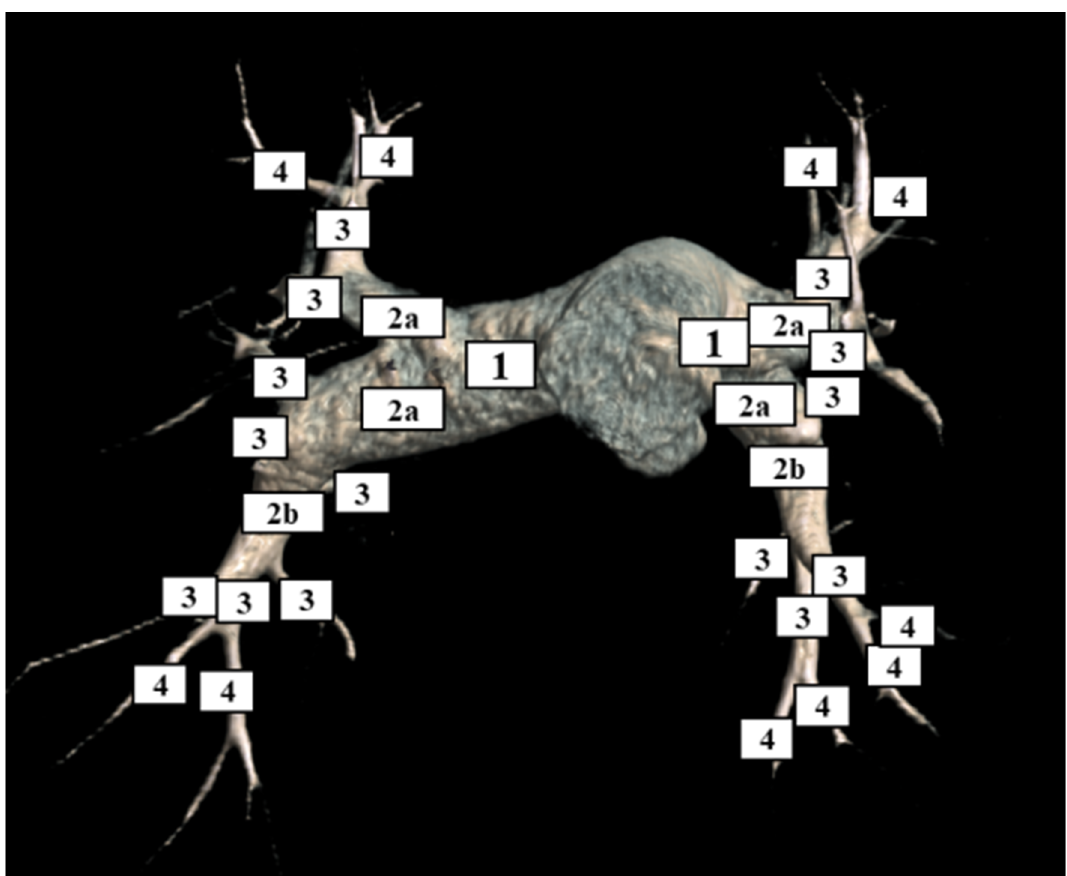
Figure 1. Computed tomography volume rendering of the pulmonary arteries illustrating the classification of the level of disease in patients with chronic thromboembolic pulmonary hypertension. The classification is based on the location of the most proximal thrombus. Level 1 disease was defined as any disease involving the main, left, or right main pulmonary arteries. Level 2a disease was defined as any disease in the interlobar or lobar pulmonary arteries. Level 2b disease was defined as disease in the basal trunk of the pulmonary artery of the lower lobe distal to the superior segmental vessel origin. Level 3 disease was defined as disease in the segmental pulmonary arteries within 1 cm of its origin. Level 4 disease was defined as disease more distal than 1 cm from the origin of the segmental vessel, including the subsegmental vessels.